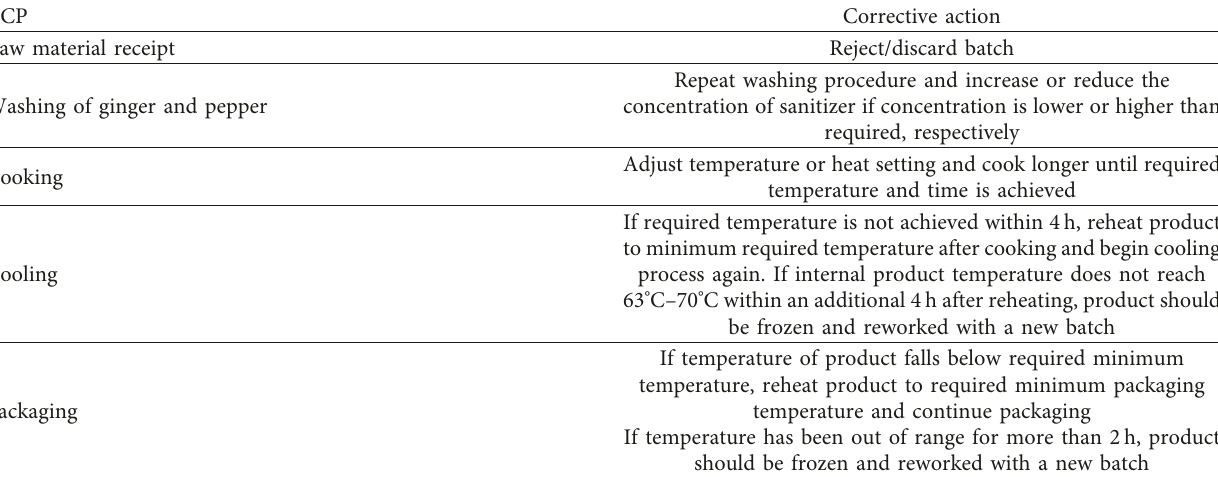
Table 4: Corrective actions at the critical control points in case of deviations from the critical limits.